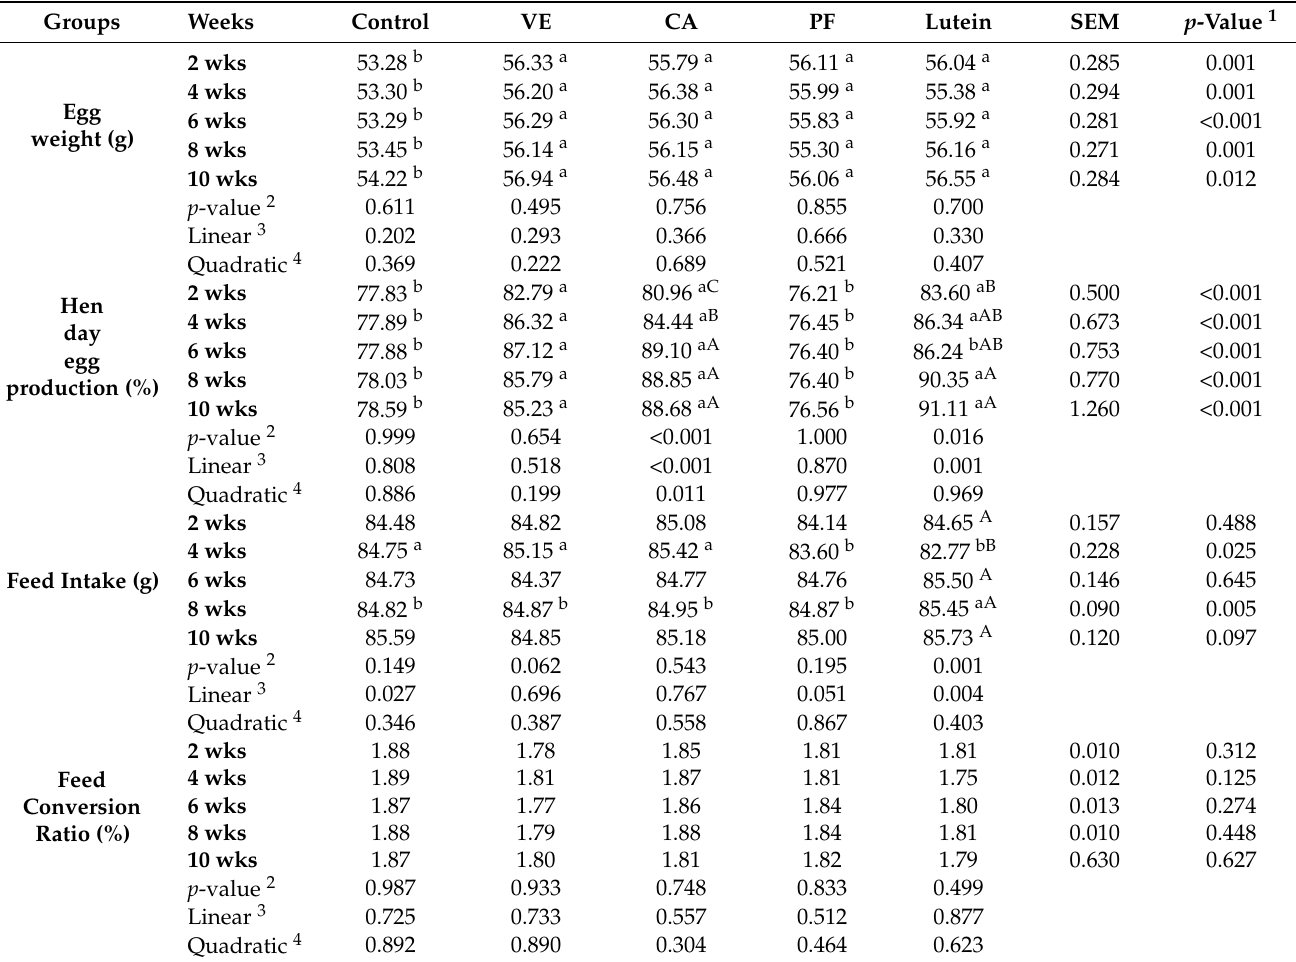
Table 3. The effect of different antioxidants on laying hens’